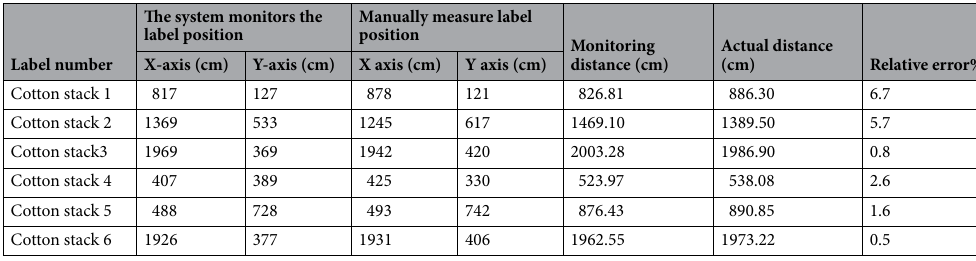
Table 5. RFID tag error measurement test